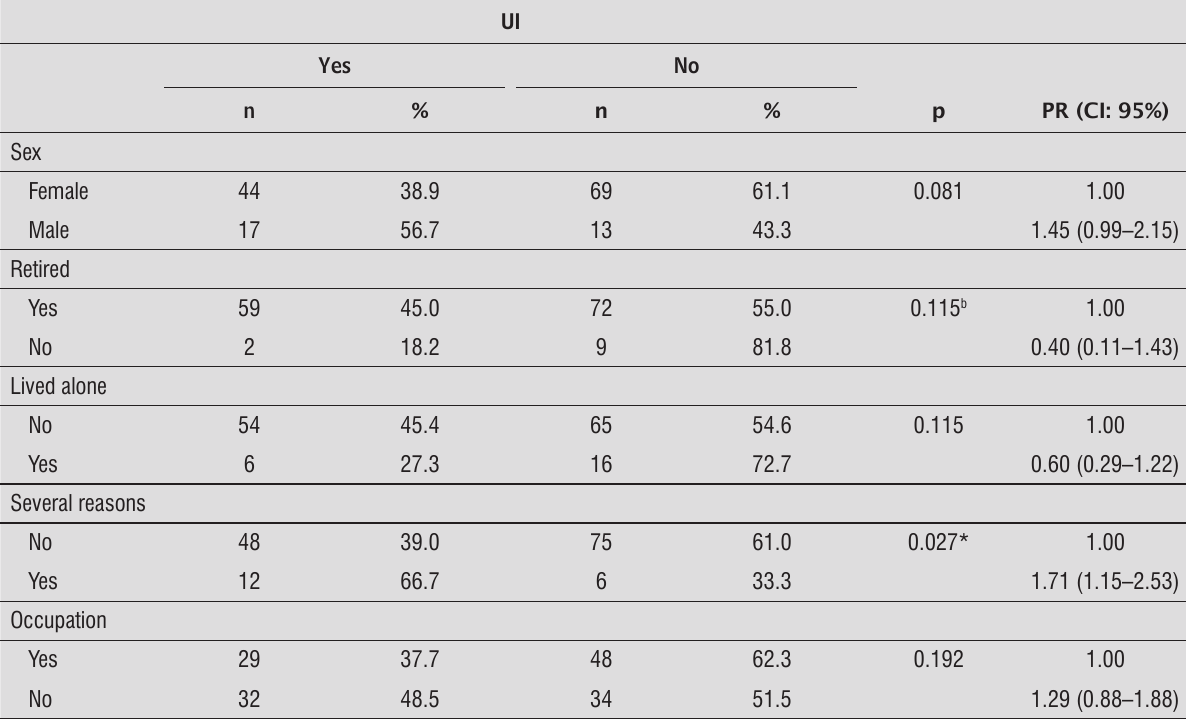
Table 3 - Association between UI and sex and those independent variables with p value under 0.20 – Natal (RN),